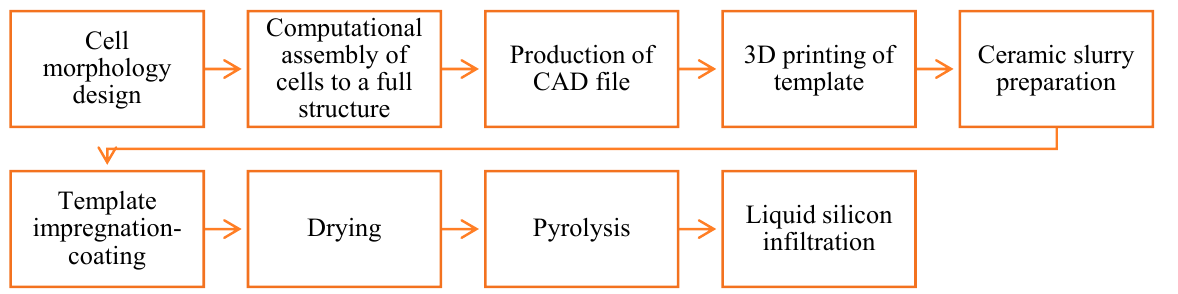
Figure 2. Production steps to fabricate SiSiC lattices using the replica method. Table 2. Pros and cons of the replica method. Pros